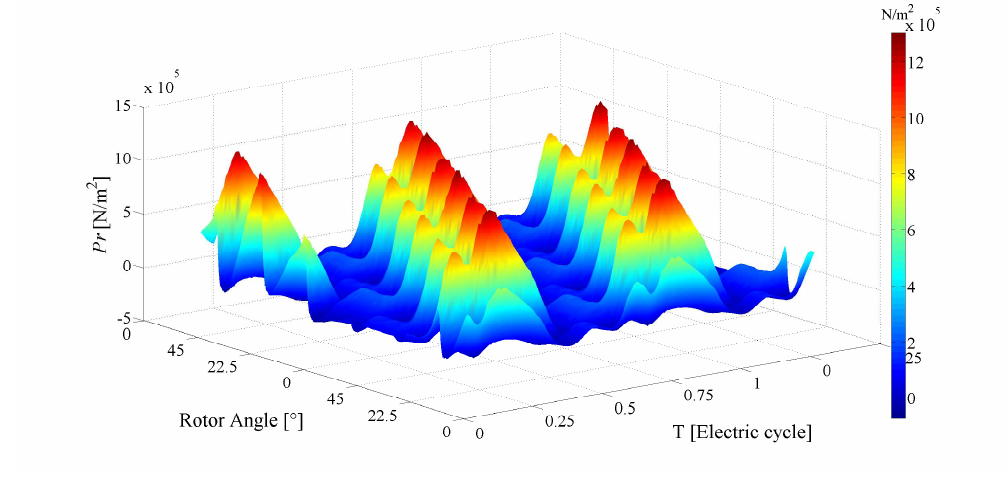
Figure 12. The radial